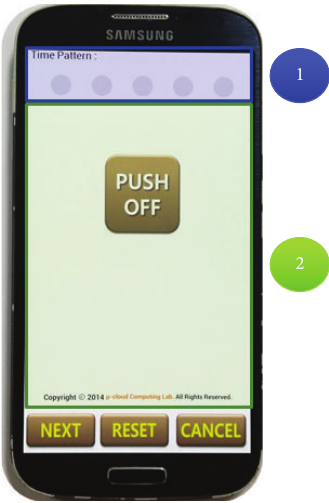
Figure 4: Initial execution screen of